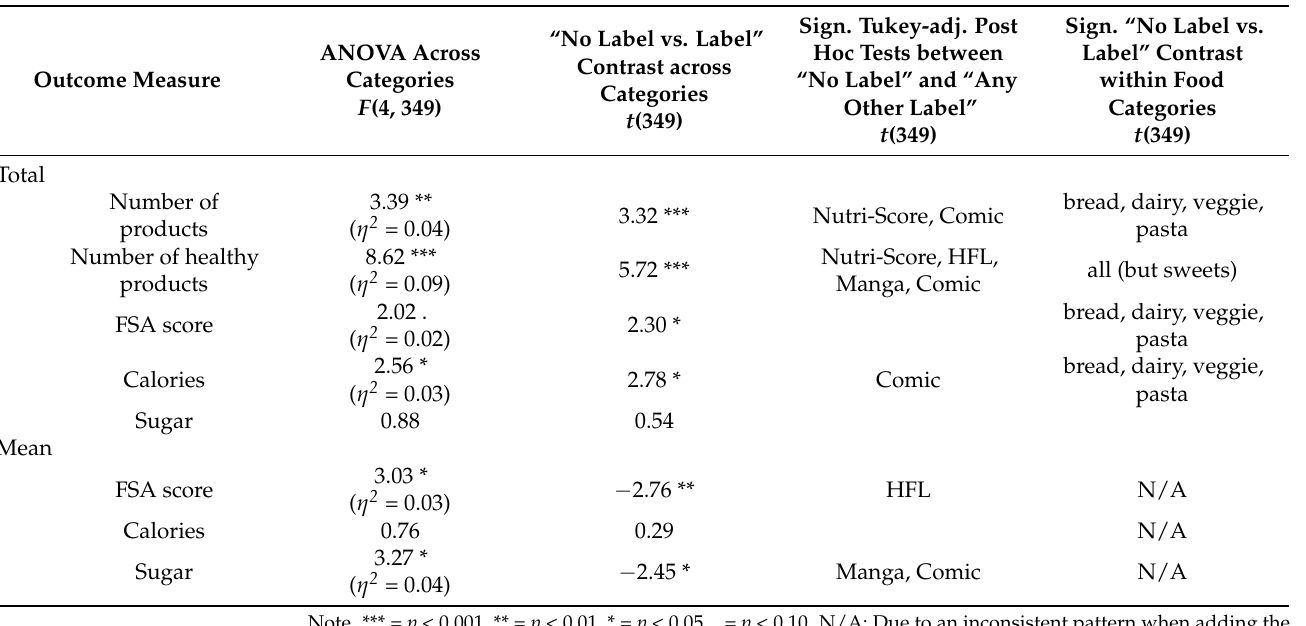
Table 2. Results of the ANOVAs for the different outcome measures (or operationalizations).